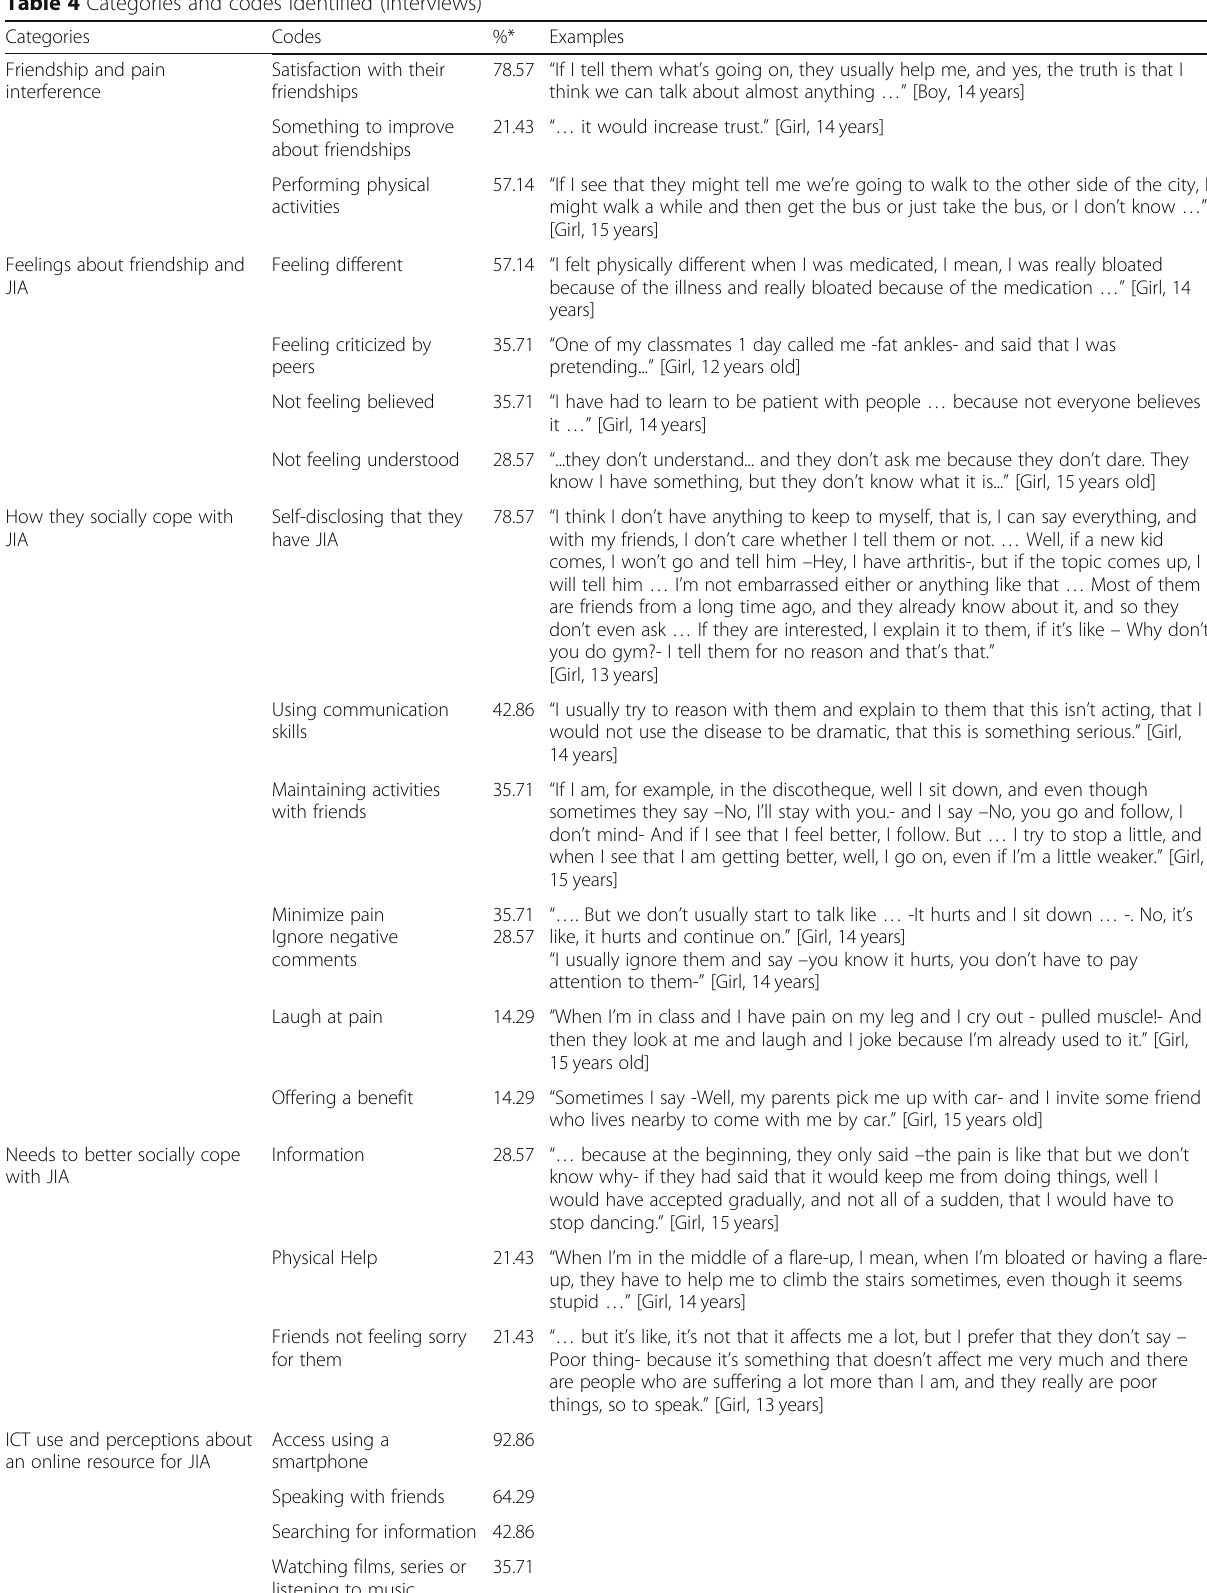
Table 4 Categories and codes identified (interviews)